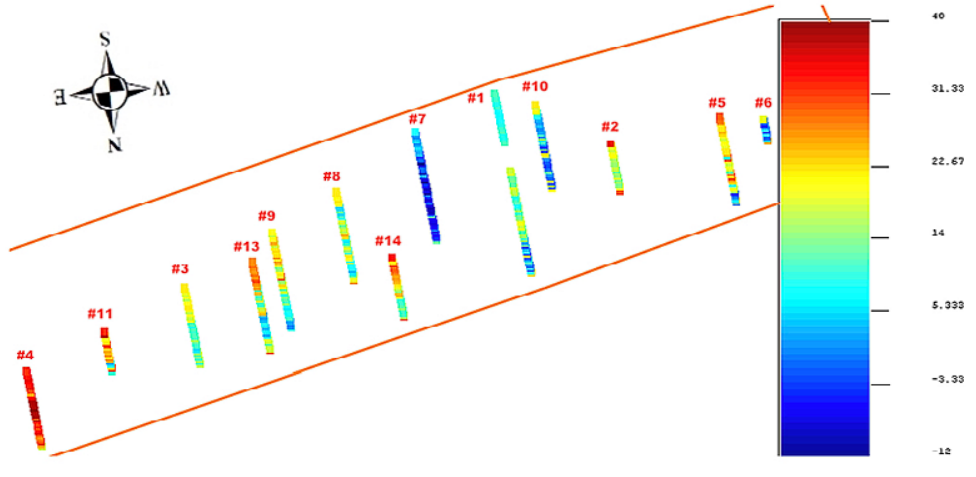
Figure 7b. SP Well Data Logs with well ID numbers within study area